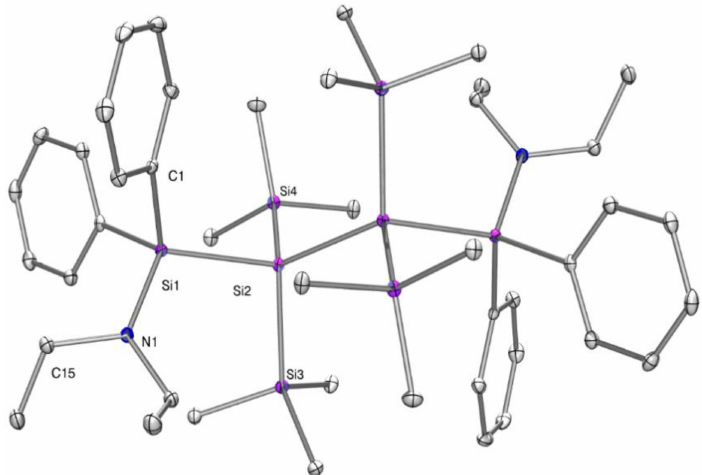
Figure 7. Molecular structure of 4 (thermal ellipsoid plot drawn at the 30% probability level). All hydrogen atoms are omitted for clarity (bond lengths in Å, angles in degrees). Si(1)-Si(2) 2.426(2) Si(2)-Si(4) 2.394(3), Si(2)-Si(3) 2.410(3), Si(2)-Si(2A) 2.464(4), Si(1)-C(18) 1.875(4), Si(1)-N(1) 1.727(3), N(1)-C(15) 1.473(4), Si(1)-Si(2)-Si(2a) 117.04(5), Si(3)-Si(2)-Si(4)